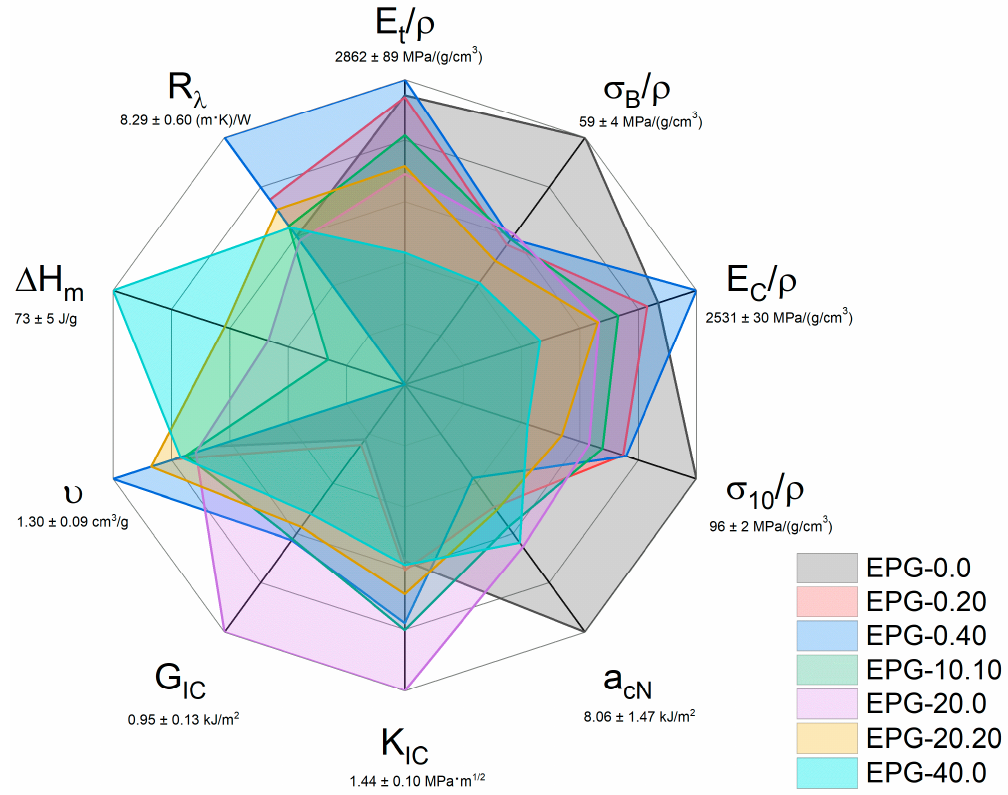
Figure 8. Graphical representation of the properties of some representative compositions analyzed in this paper and in our previous work on these foams [30].